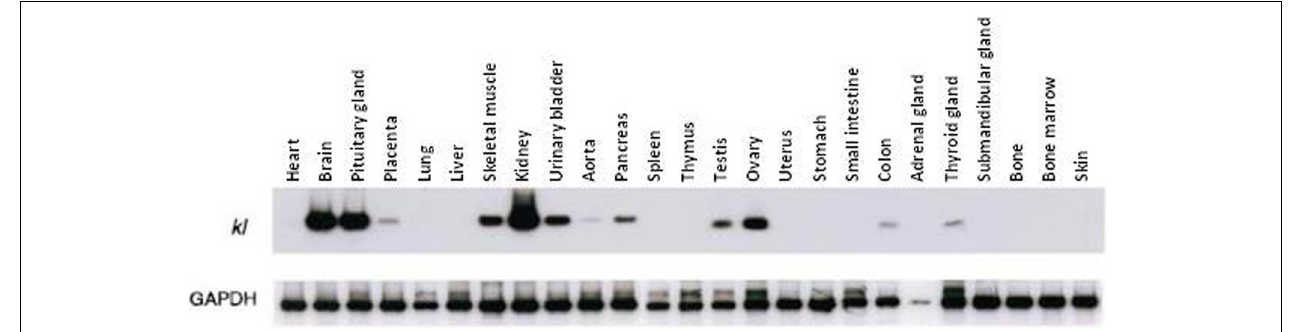
FIGURE 1 | Klotho gene expression in multiple tissues. Kuro-o and colleagues quantified Klotho gene expression of multiple tissues using RT–PCR. The kidney, brain and pituitary gland demonstrate the